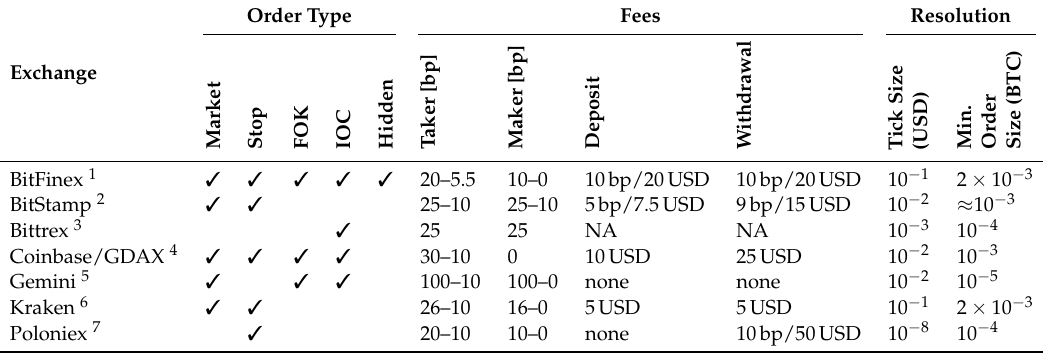
Table 1. Comparison of cryptocurrency limit order exchanges along the dimensions order type, fee structure and resolution parameters. FOK : fill-or-kill orders, IOC : immediate-or-cancel orders, hidden : publicly invisible limit orders, taker fees : range of fees payable for taking liquidity from the market, maker fees : range of fees payable when submitting orders subsequently taken by other